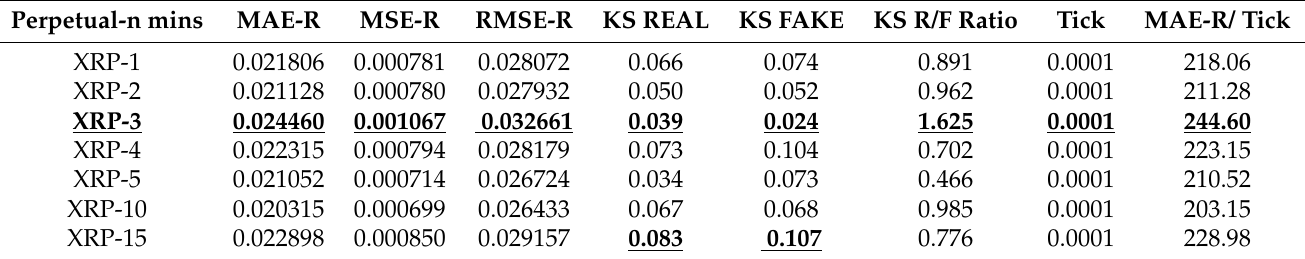
Table 20. We compared XRPUSDT perpetual futures at multiple time intervals. XRP-3 has the largest MAE-R among all